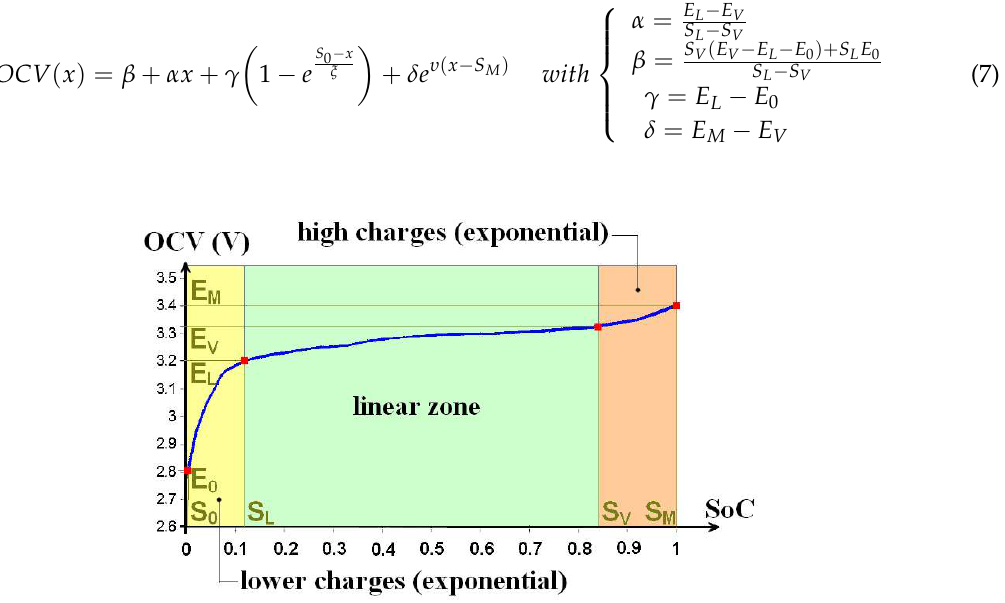
Figure 10. Example of a characteristic curve representation linking the open-circuit voltage to the state of charge for a LiFePO 4 cell.